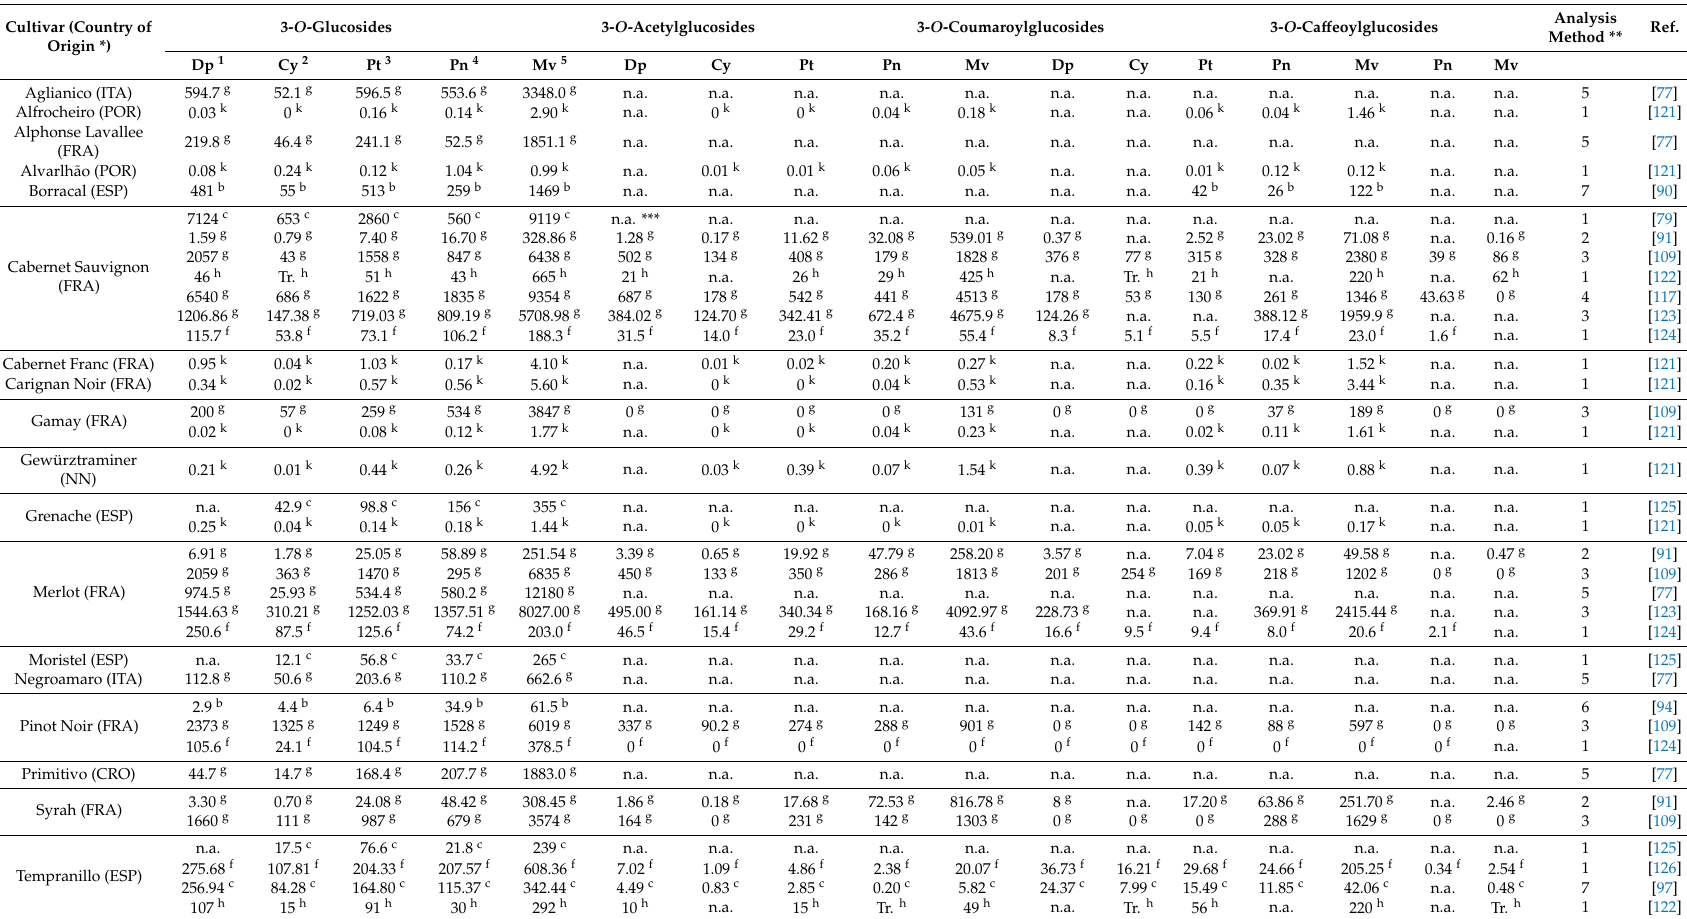
Table 4. Contents of individual anthocyanins in the grapes of di ff erent red grapevine